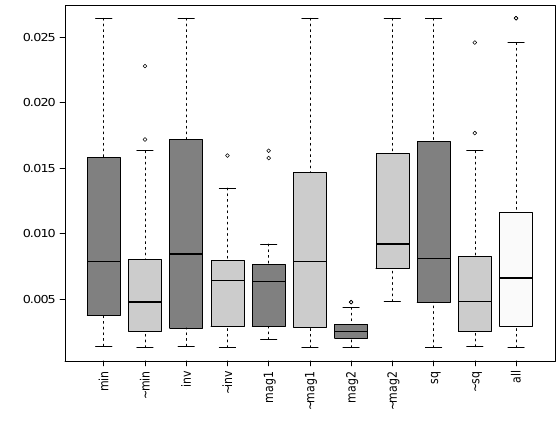
Fig. 8. Comparison of the mean c mse score on runs with function set sizes of 11, grouped by the presence or absence of particular functions g . Boxplot conventions as in Fig.